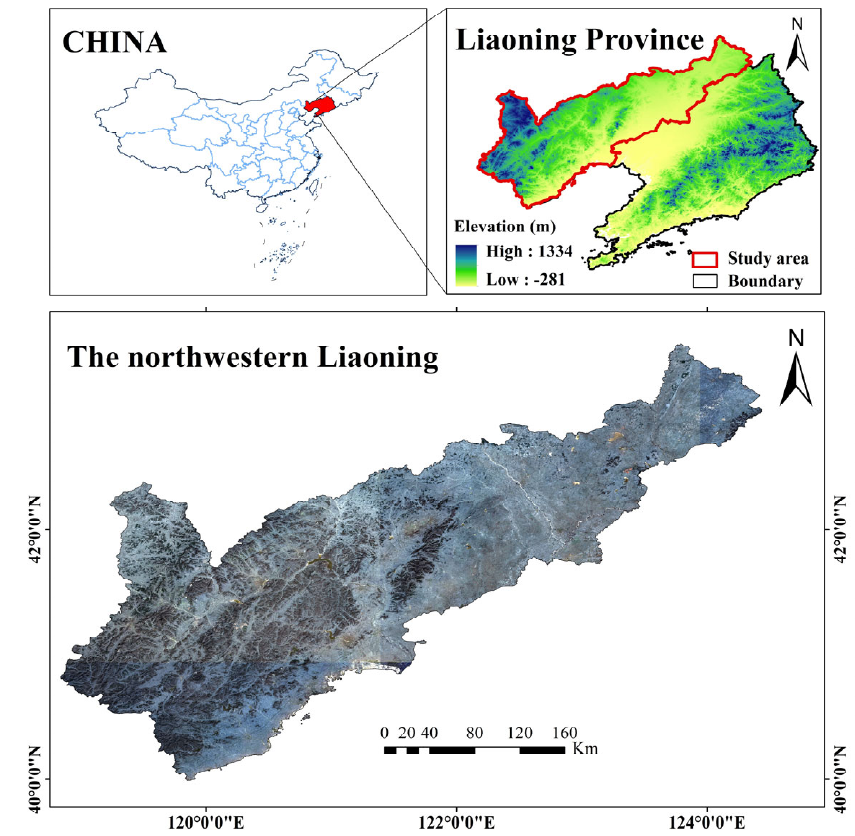
Figure 1. The location of the study area.